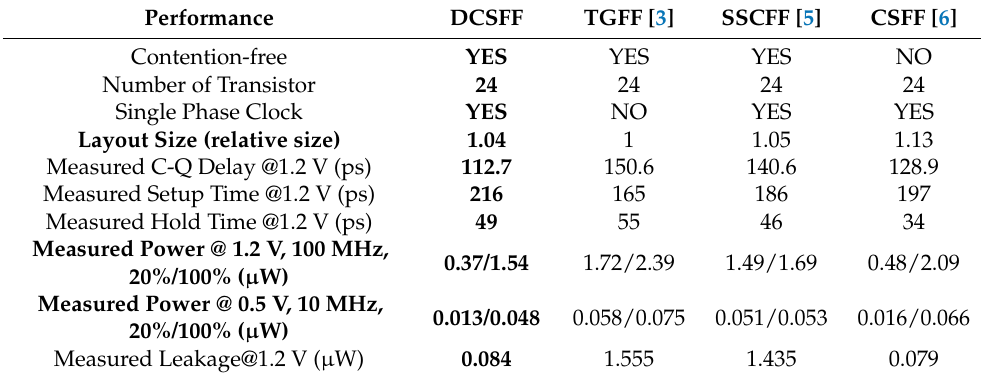
Table 1. Performance Comparison Table between DCSFF and Other